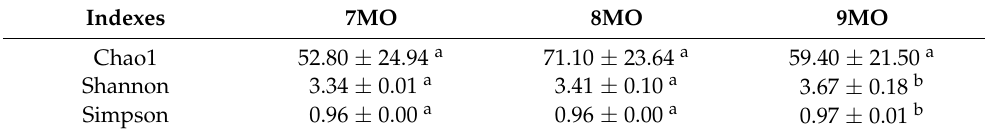
Table 1. Summary of alpha diversity for intestinal microbiota from Seriolella violacea . Indexes